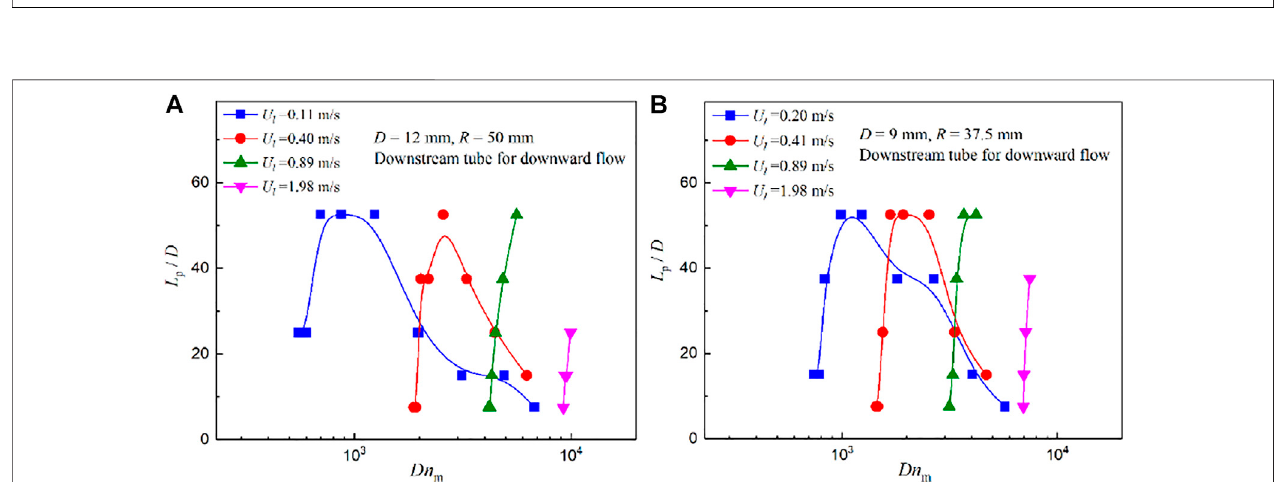
FIGURE 9 | Effect of the mixed Weber number We m on the dimensionless perturbation length L p / D . (A) Downstream tube for downward fl ow D = 12 mm, R = 50 mm and (B) Downstream tube for downward fl ow D = 9 mm R = 37.5 mm.